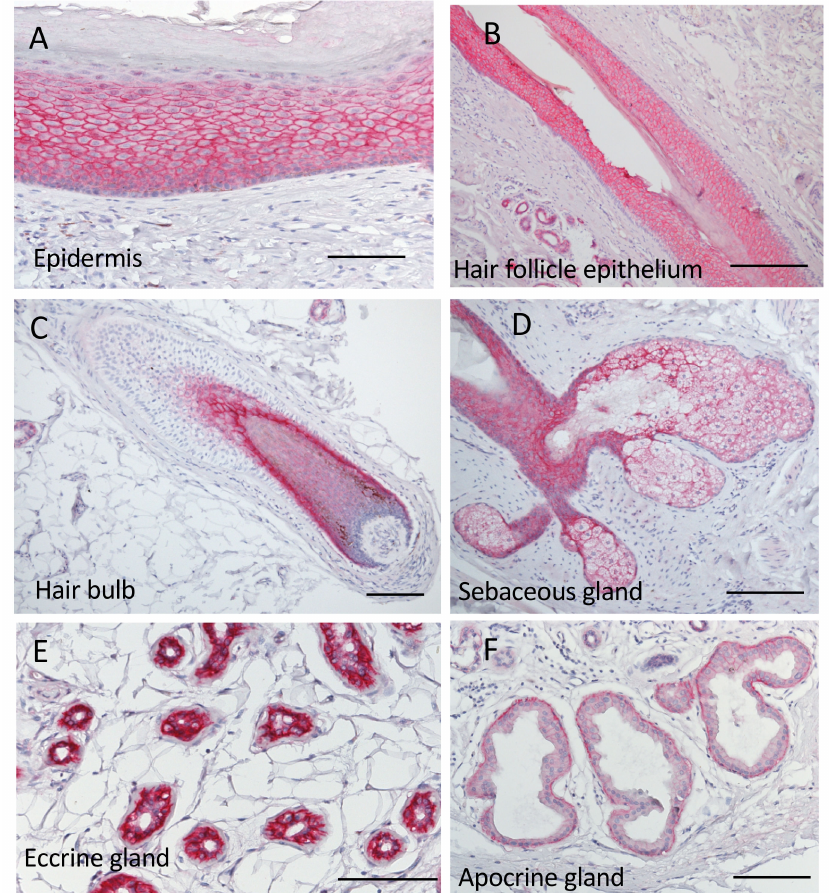
Figure 1. Representative histopathological images of Trop2 staining in human normal skin and skin appendages. Positive signals are presented in red. ( A ) Epidermis. The epidermal keratinocytes exhib- ited negative to faint staining in the basal layer, strong membranous and weak cytoplasmic staining in the spinous layer, and no membranous or cytoplasmic Trop2 expression in the granular layer. A few cells of granular layer had weak nuclear staining. ( B ) Hair follicle epithelium. Keratinocytes in the infundibulum and isthmus displayed a similar expression pattern as that observed in the epidermis. ( C ) Hair bulb. Trop2 staining was positive in the inner root sheath (membranous 3+, cytoplasmic 3+), matrix (membranous 1+, cytoplasmic 1+), and cortex (membranous 1+, cytoplasmic 1+) but negative in hair germ cells and the outer root sheath. ( D ) Sebaceous gland. Trop2 staining was strongly positive (membranous 3+, cytoplasmic 3+). ( E ) Eccrine gland. Trop2 staining was strongly positive (membranous 3+, cytoplasmic 3+). ( F ) Apocrine gland. Trop2 staining was moderately positive (membranous 2+, cytoplasmic 1+). Bars indicate 100 µ m. Trop2, trophoblast cell surface antigen